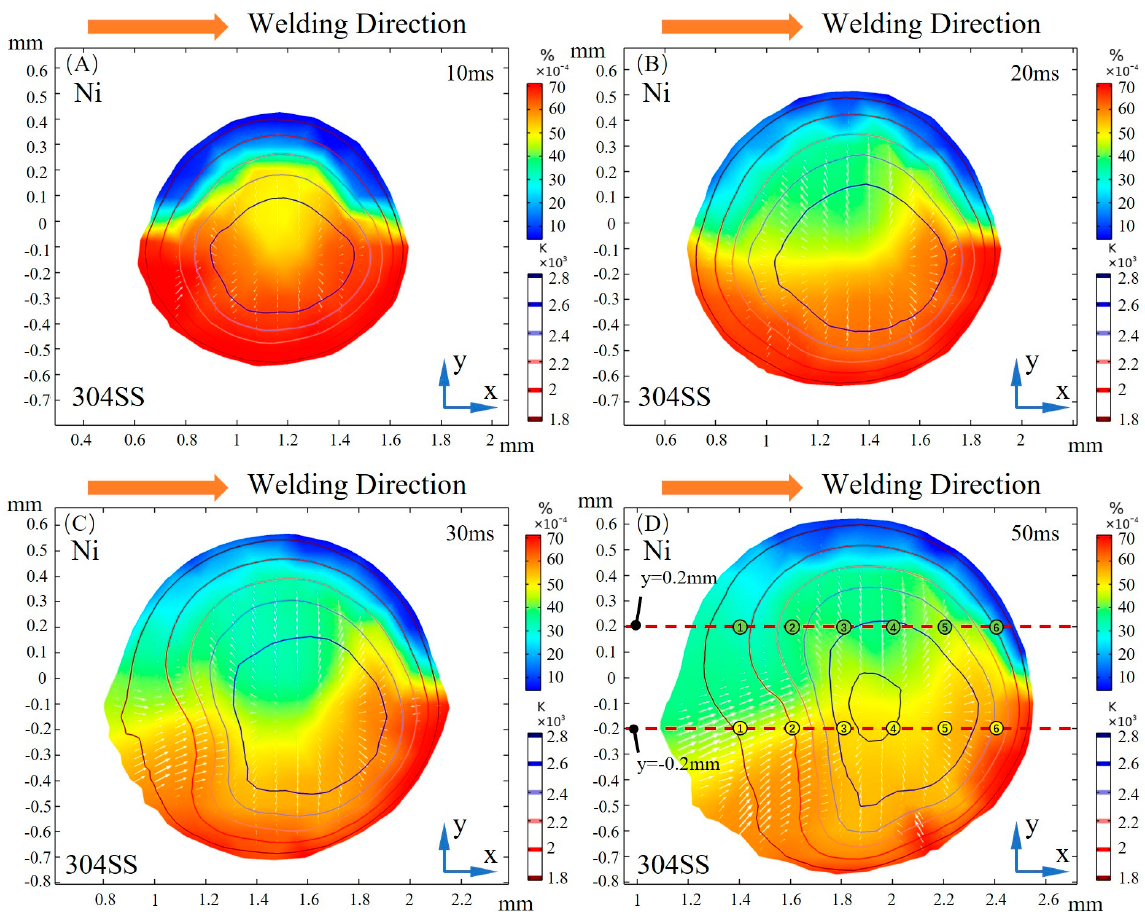
Figure 3. Dilution of sulfur on the free surface at different times. ( A ) 10 ms; ( B ) 20 ms; ( C ) 30 ms; ( D ) 50 ms.